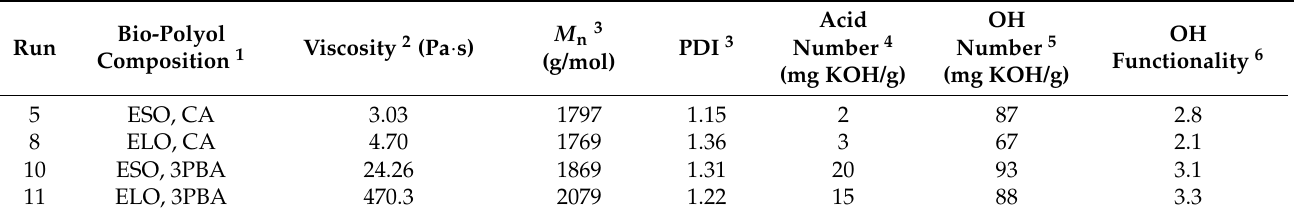
Table 2. Properties of selected